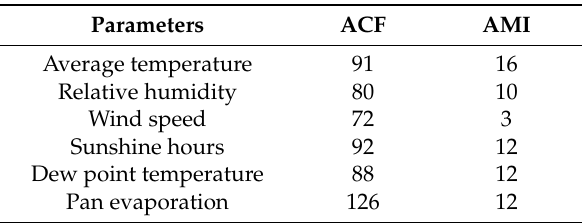
Table 3. Autocorrelation function (ACF) and average mutual information (AMI) values for all of the parameters at Kosice